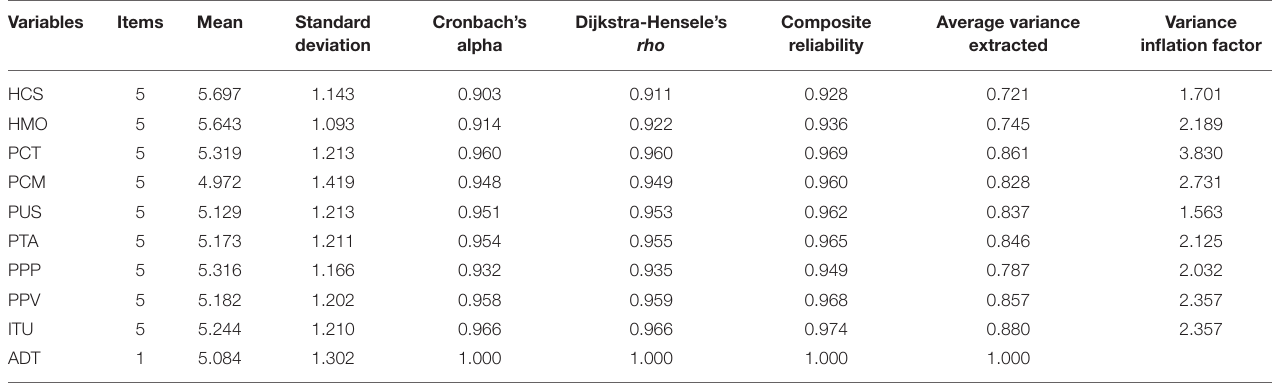
TABLE 2 | Reliability and validity.